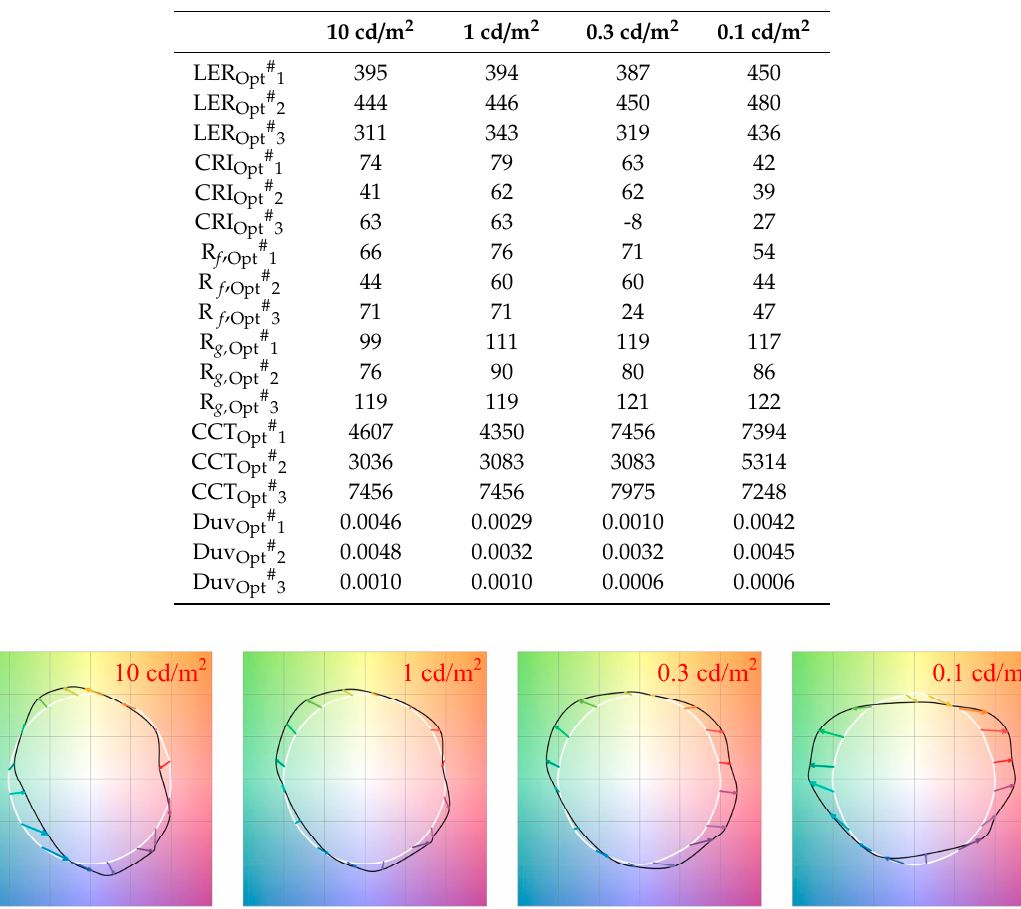
Figure 4. Color vector graphic of Opt # 1 optimal SPDs.